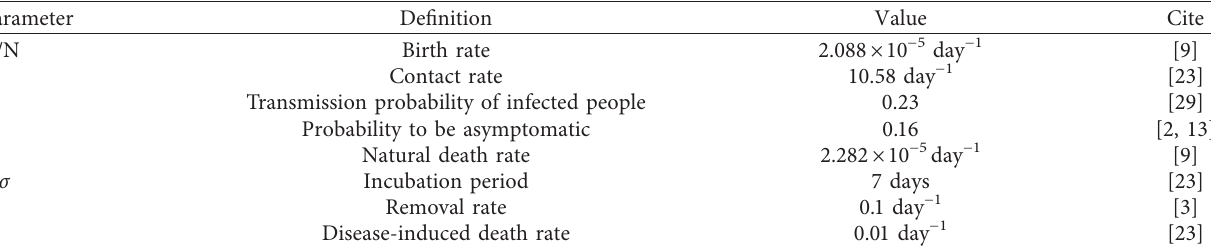
Table 1: Values of the model parameters.